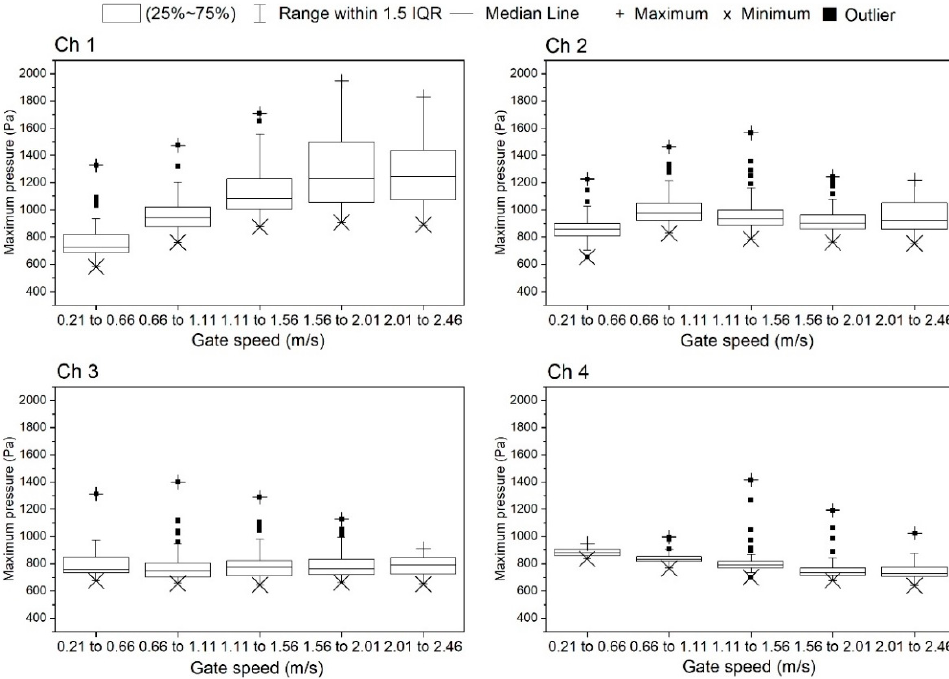
Figure 4. Box plots showing the relationship between gate speed and maximum pressure; the box plots also display the position of the minimum, first quartile (Q1), median, third quartile (Q3), and maximum pressure. The dots denote statistical outliers. Ch1, Ch2, Ch3, and Ch4 are located at 0.7, 1.3, 1.9, and 2.2 m from the gate, respectively.